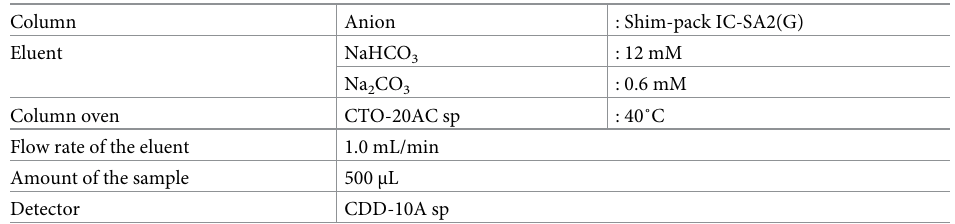
Table 1. Ion chromatography operating